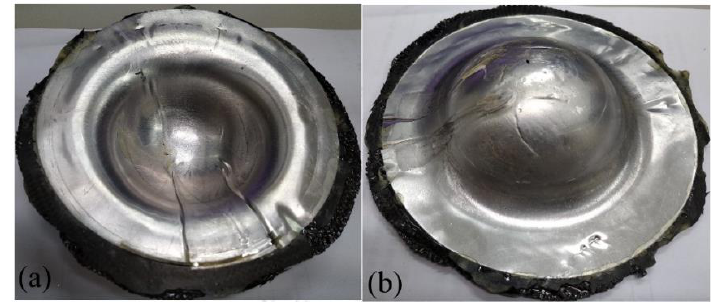
Figure 12. Deep drawing of Al 6061-composite sandwich with 230 °C preheating: ( a ) front view, ( b ) back view.